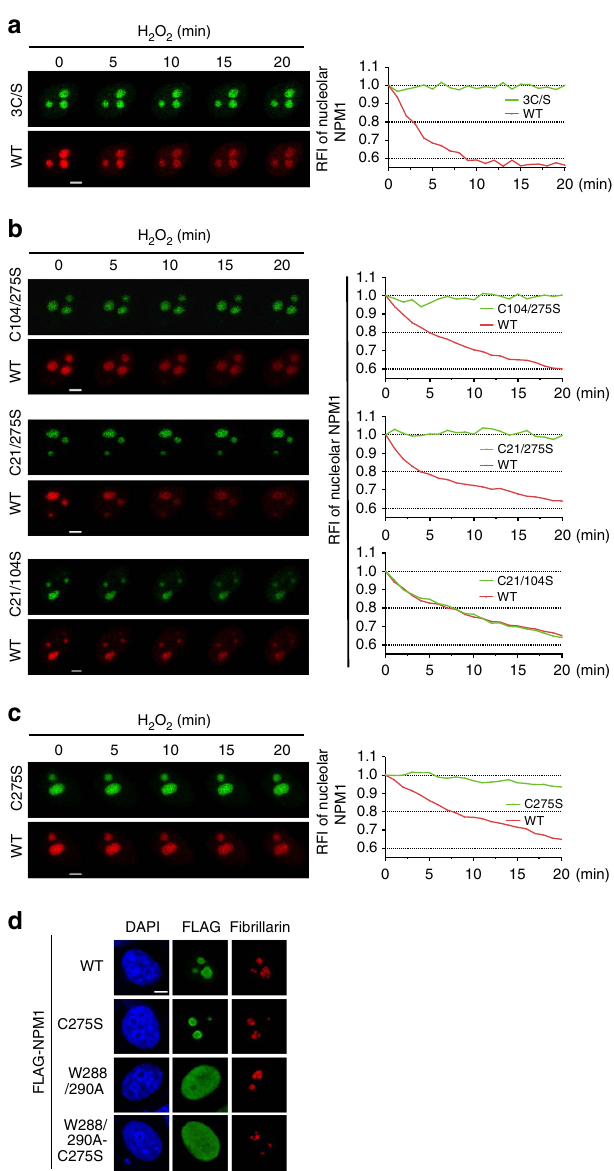
Figure 3 | Cys 275 oxidation is responsible for NPM1 translocation. ( a – c ) Translocation of mCherry-NPM1 WT and EGFP-NPM1 mutants in identical cells upon H 2 O 2 (500 m M) exposure, visualized by live-cell imaging for 20min. ( d ) Localization of various FLAG-NPM1 mutants in unstressed HeLa cells. Scale bars, 5 m m. 3C/S, C21/104/275S. NATURE COMMUNICATIONS|7:13599|DOI: